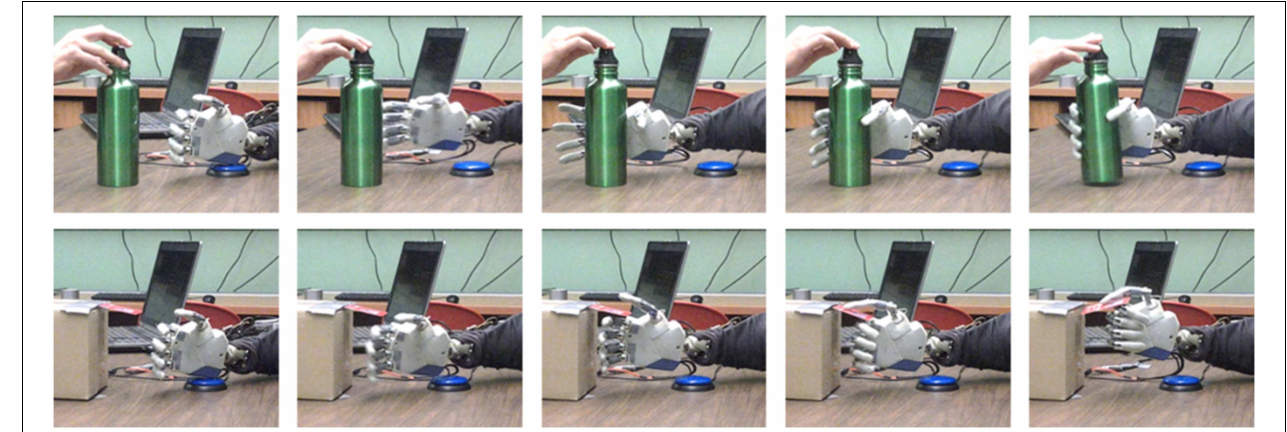
FIGURE 7 | Grasp pre-shaping with closed loop real-time hand neuroprosthetic control based on EEG. Examples of successful grasps during the closed-loop control are shown for the cylindrical ( top row ) and the lateral ( bottom row ) grasps. Videos of the shown task are available in the Supplementary Section.